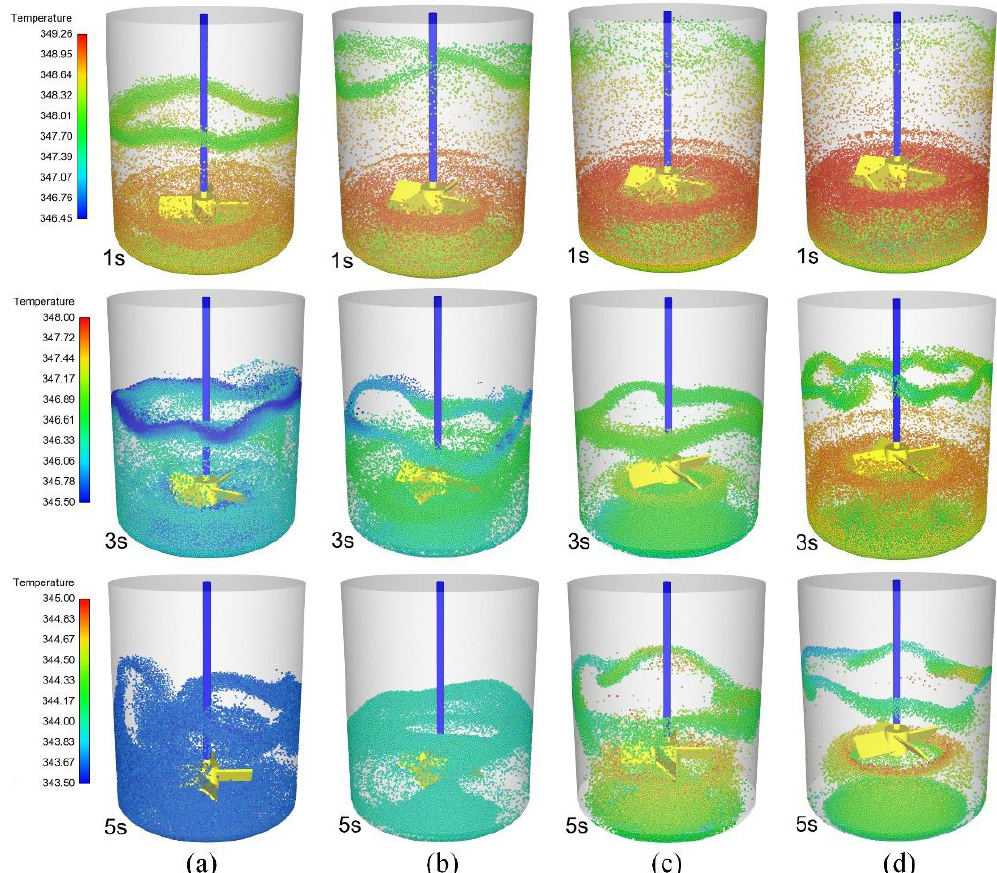
Figure 10. Schematic diagram of temperature and distribution of particles in four tanks. The height of blades is ( a ) 30 mm, time respectively 1 s, 3 s, 5 s. ( b ) 40 mm, time respectively 1 s, 3 s, 5 s. ( c ) 50 mm, time respectively 1 s, 3 s, 5 s. ( d ) 60 mm time respectively 1 s, 3 s, 5 s.